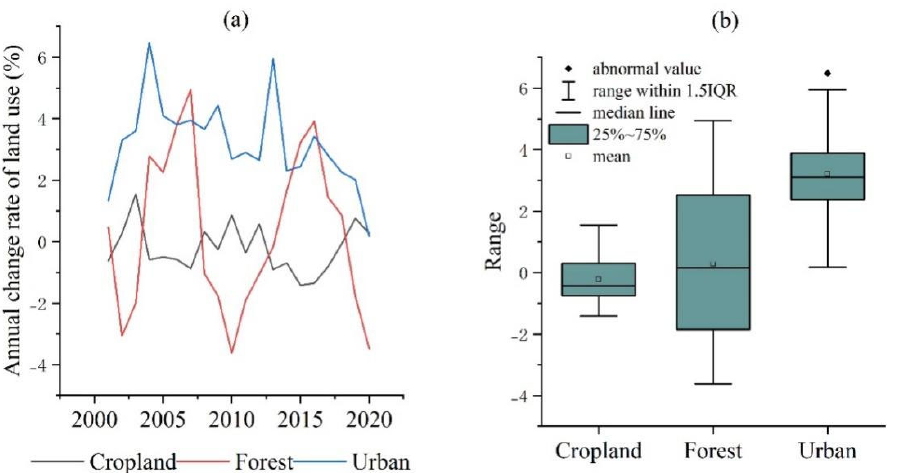
Figure 6. Cropland, forest, urban annual rate of change of land use (%). ( a ) Cropland, forest, urban annual change rate (%); ( b ) Box plot of the annual change rate.